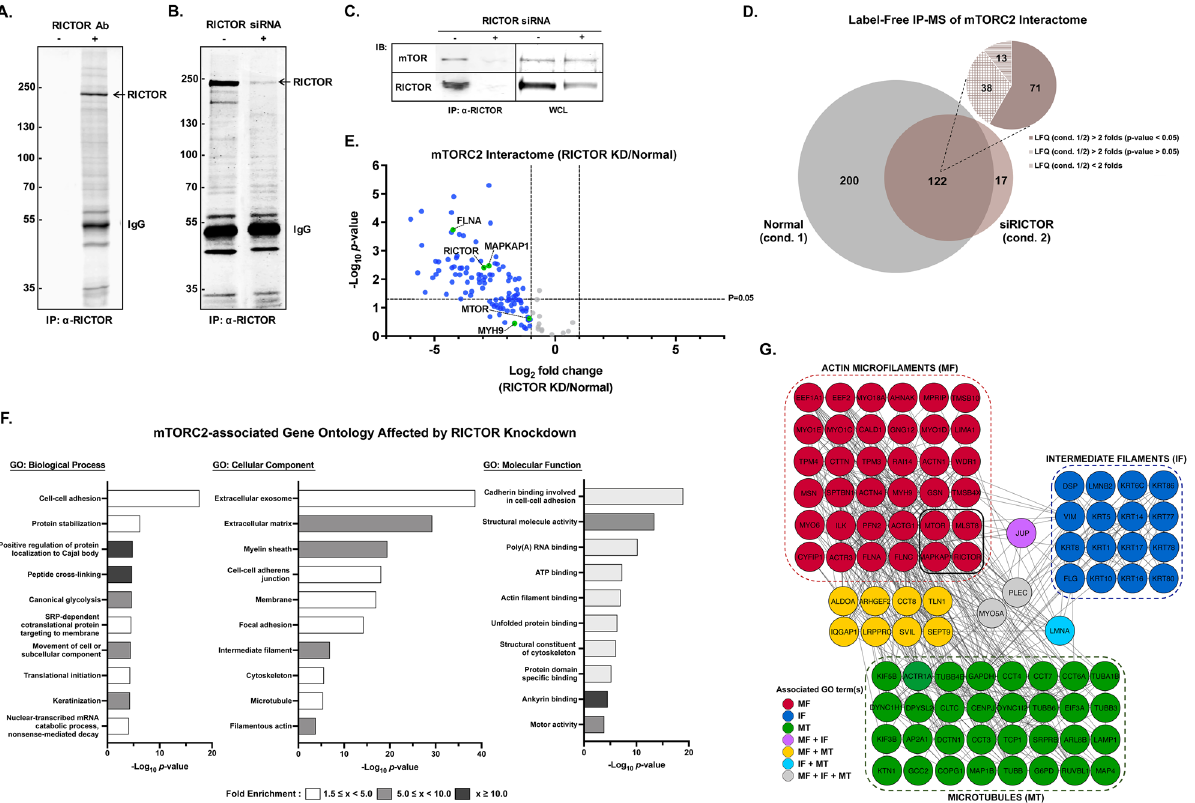
Figure 3. Identification of the mTORC2 interactome by AP-MS. (A) Coomassie-stained SDS-PAGE gel of an immunoprecipitation assay using protein A magnetic beads incubated with or without anti-RICTOR antibody. (B) Coomassie-stained SDS-PAGE gel of RICTOR-IP comparing the control U87MG cells and siRICTOR- treated cells. (C) Western blot analysis of immunoprecipitated RICTOR samples and whole-cell lysate (WCL) of U87MG cells treated with RICTOR siRNA compared to the control. (D) mTORC2-interacting proteins identified by AP-MS analysis compared between normal and RICTOR knockdown cells as in (B); n = 3 biological replicates. (E) Volcano plots of the results of the AP-MS experiment in (D) showing mTORC2-associated proteins affected by RICTOR knockdown. Proteins with a fold change (LFQ siRICTOR/normal) ≥ 2 are shown in blue. Known mTORC2 components and interacting proteins are shown in green circles. (F) Gene ontology analysis of 309 proteins negatively affected by RICTOR knockdown (decreased by at least twofold or absent in siRICTOR-treated IP samples). Ten top-ranked -log 10 ( p -value) GOBP, GOCC, and GOMF terms with FDR < 0.05 are shown. (G) mTORC2-interacting protein–protein network based on cytoskeleton-associated proteins from blue circles in (E) affected by RICTOR knockdown. Proteins associated with each group of the cytoskeleton were labeled with different colors. Known key components of mTORC2 are in the black-bordered